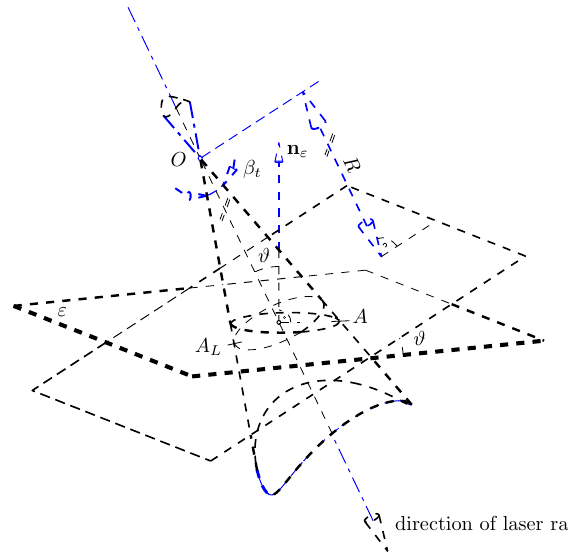
Figure 1: Geometric parameters of the radar equation. The angle ϑ formed by the laser ray and the normal of of the target plane ε is called incidence angle (Roncat et al.,